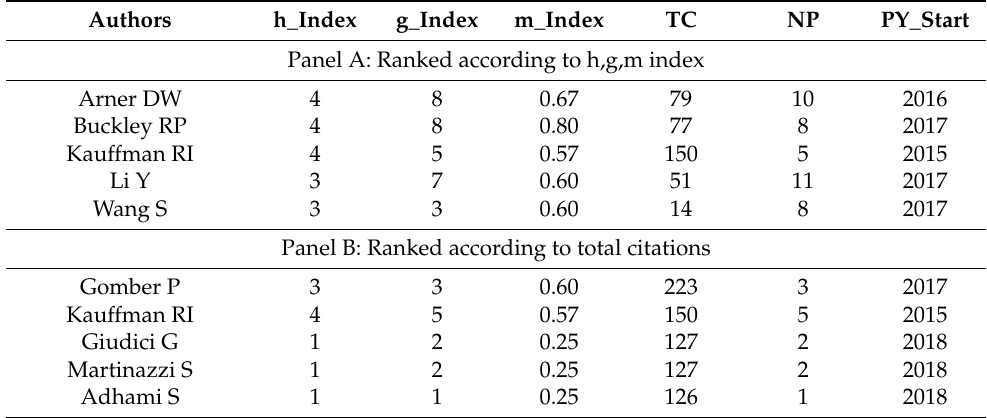
Table 3. Top authors in fintech